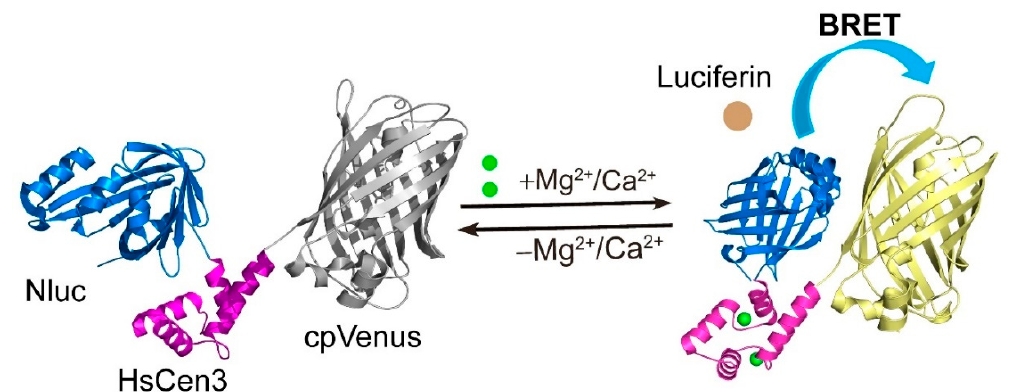
Figure 1. Schematic of Mg 2 + and Ca 2 + sensing mechanism in the water hardness indicator. HsCen3 (magenta) is an Mg 2 + and Ca 2 + binding domain, which is partially truncated for sensor function. HsCen3 is sandwiched between Nluc (blue), and cpVenus (gray) (left). Conformational changes in HsCen3, by binding of Mg 2 + or Ca 2 + , induce spatial relocation of Nluc and cpVenus, increasing the efficiency of resonance energy transfer (cpVenus showing yellow).